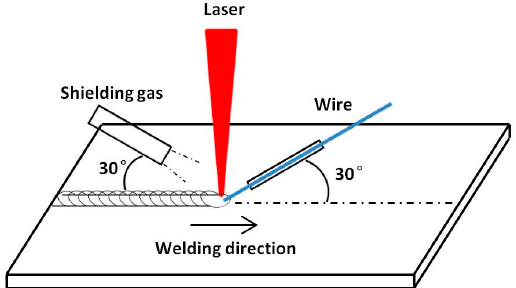
Figure 1. Experiment setup.